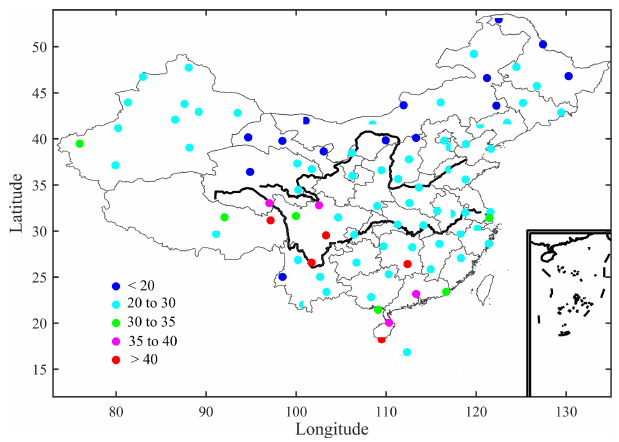
Figure 8. Spatial distribution of RMSE (Wm − 2 ) for our estimated daily SSR (spatial resolution 90km) at 90 CMA radiation